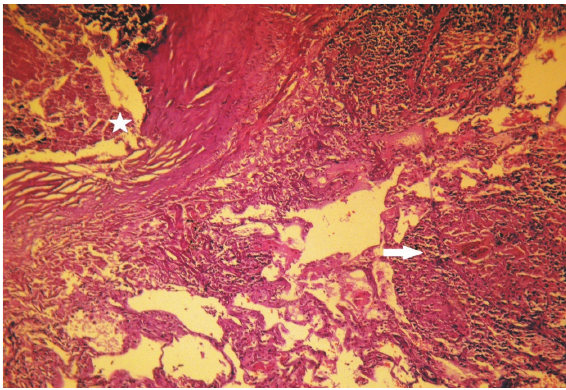
Figure 3: Pulmonary tuberculosis with caseous necrosis (asterisk) and confluent tuberculosis granulomas (arrow)